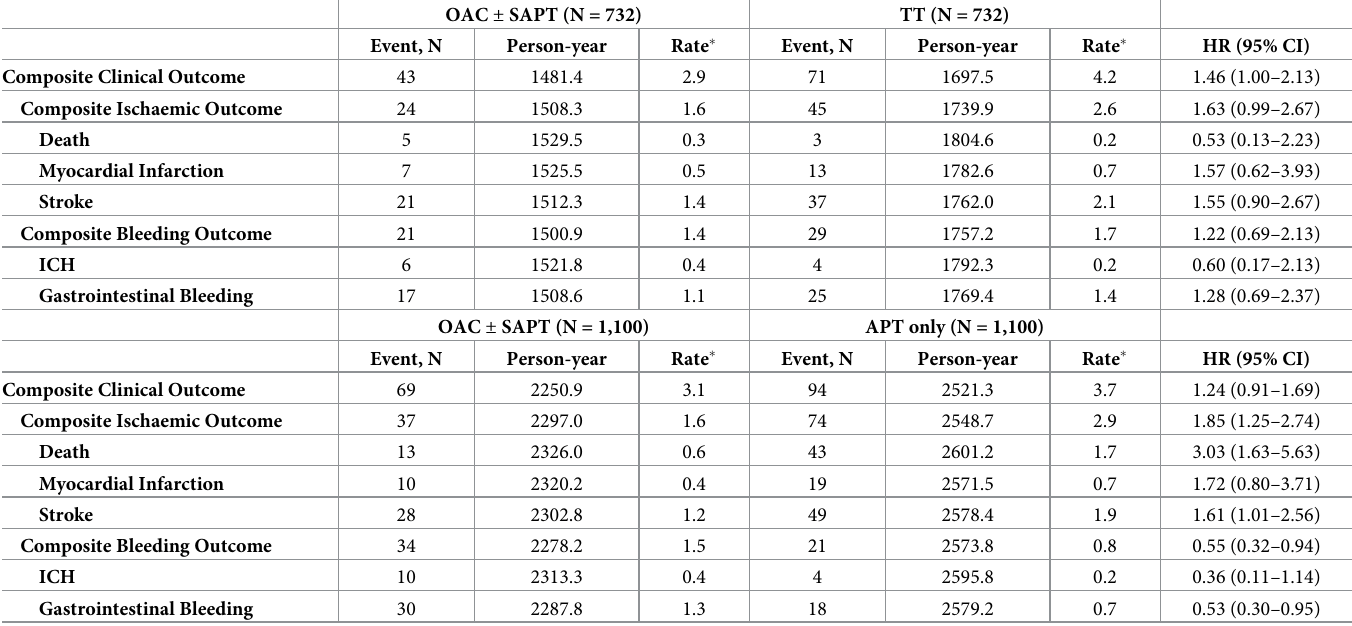
Table 4. Clinical outcome according to antithrombotic therapy at 1-year after